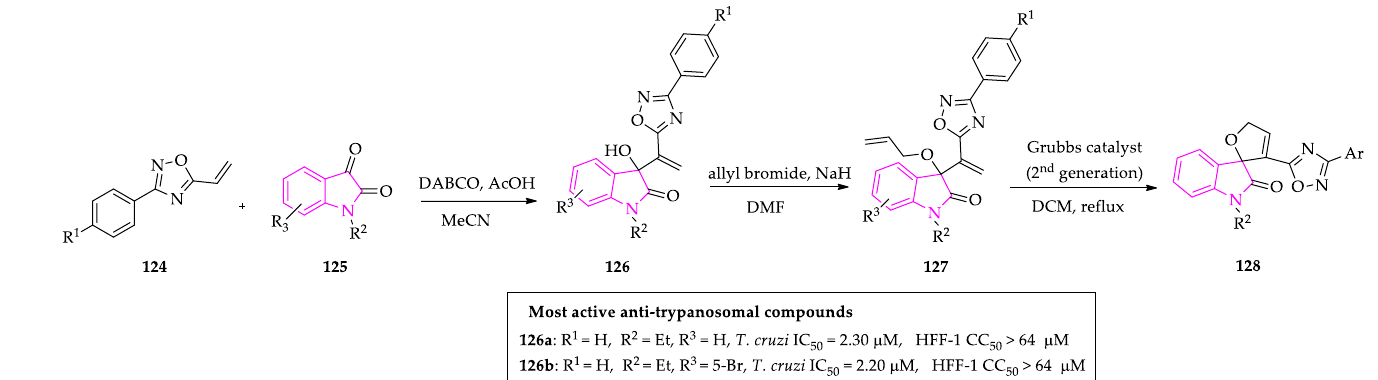
Figure 16. Rationale for structure-based design of novel hydroxyalkyl δ -lactam, δ -lactam and piperidine indole derivatives.